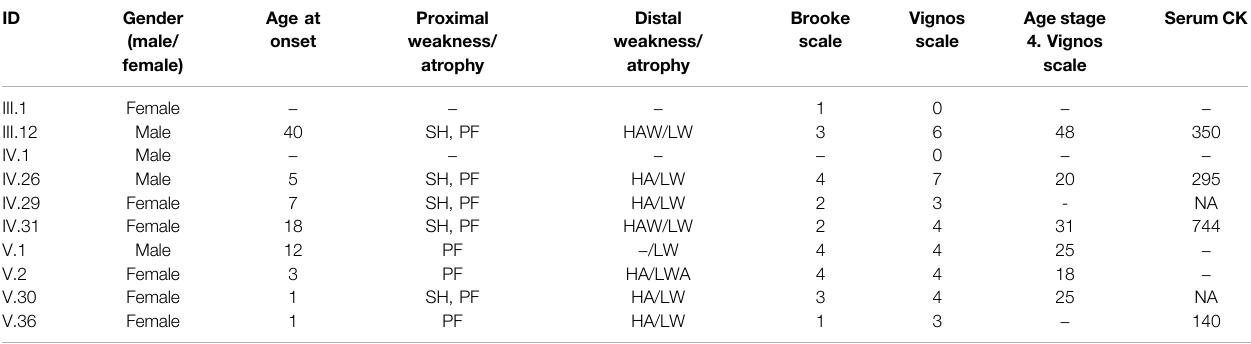
TABLE 1 | Clinical characteristics of LGMDD2 patients who were recruited for this study.